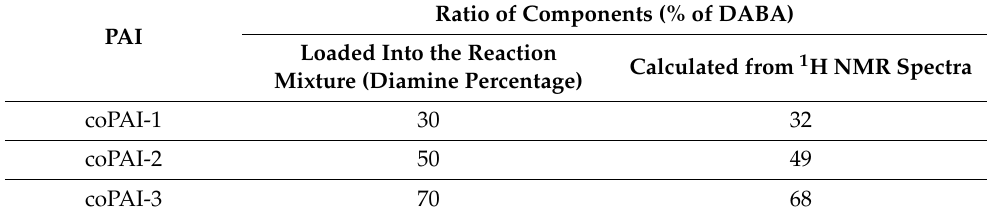
Table 1. Composition of